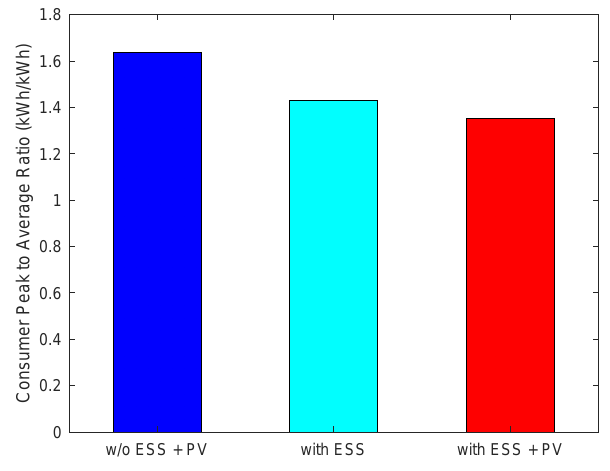
Figure 6. Consumer demand variance.